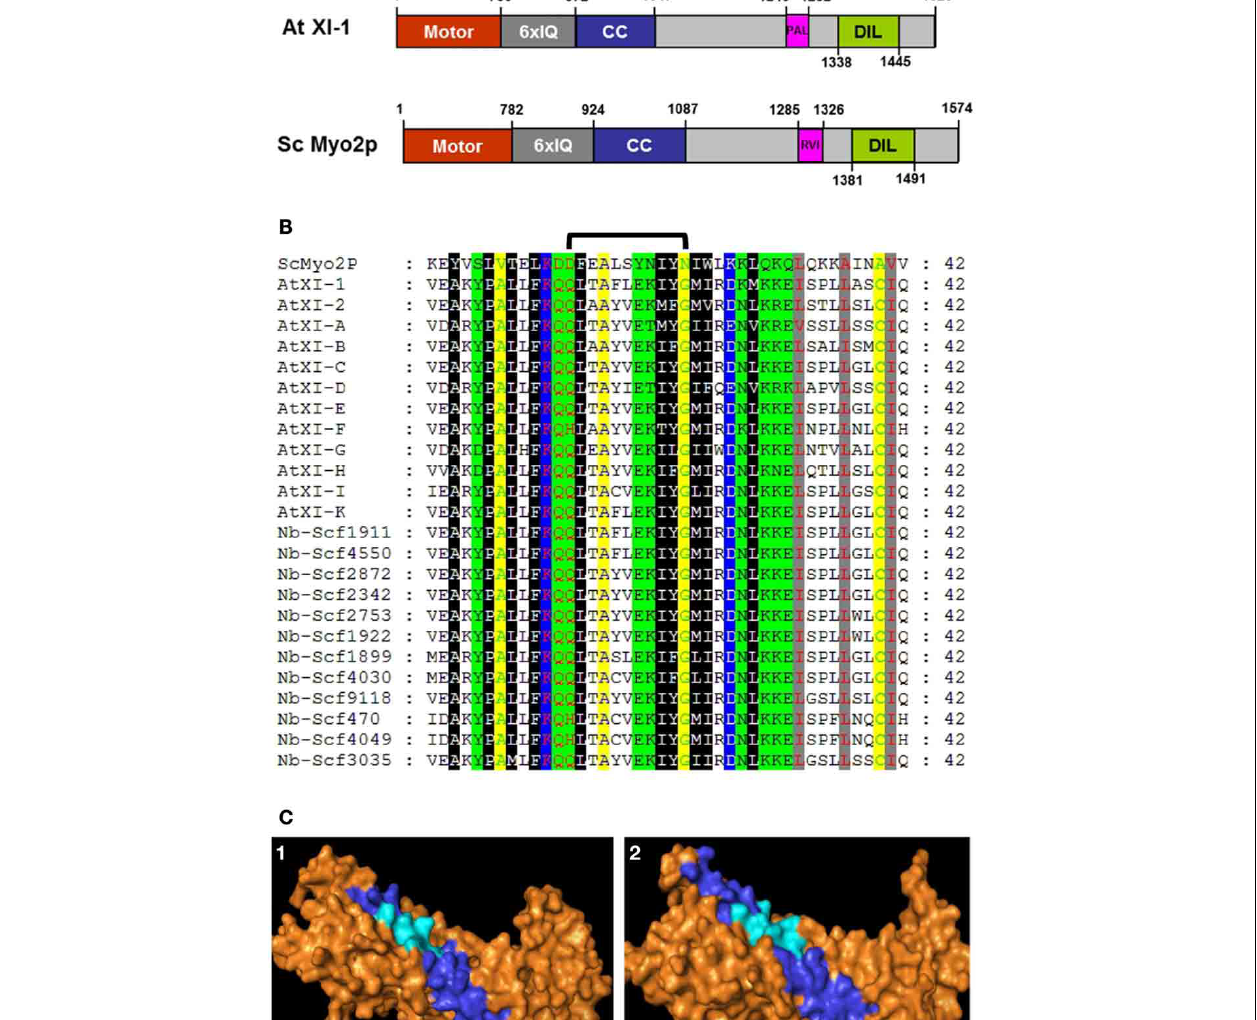
The 11 a.a region critical for vacuole binding (Catlett et al., 2000) in ScMyo2p is indicated by a bracket. (C) Homology structural modeling of myosin XI globular tail based on similarity to the myosin V ScMyo2p. Predicted three-dimensional structuresoftheglobulartailof A.thaliana classXI-Kmyosinisillustrated.(1)At XI-K, (2) ScMyo2p. Surface residues are shown in orange. The 11 amino acids critical for the vacuole binding site in ScMyo2p tail (Catlett et al., 2000) and the corresponding amino acids in PAL sub-domains are shown in cyan, while the entire 42-amino acid PAL domain is shown in dark